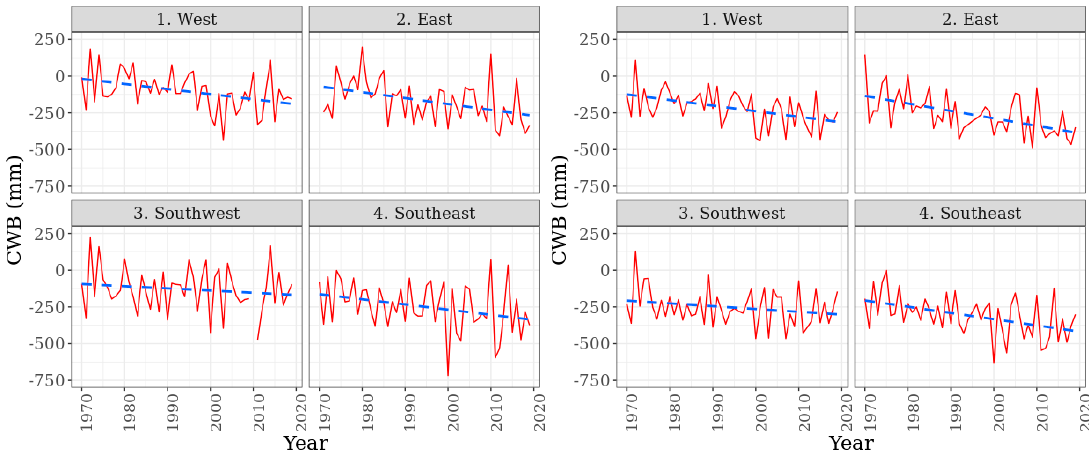
Figure 11. Annual ( left ) and seasonal * ( right ) values of the climatic water balance (CWB) in the four investigated regions. * Calculated for the vegetation period of maize (May–August).